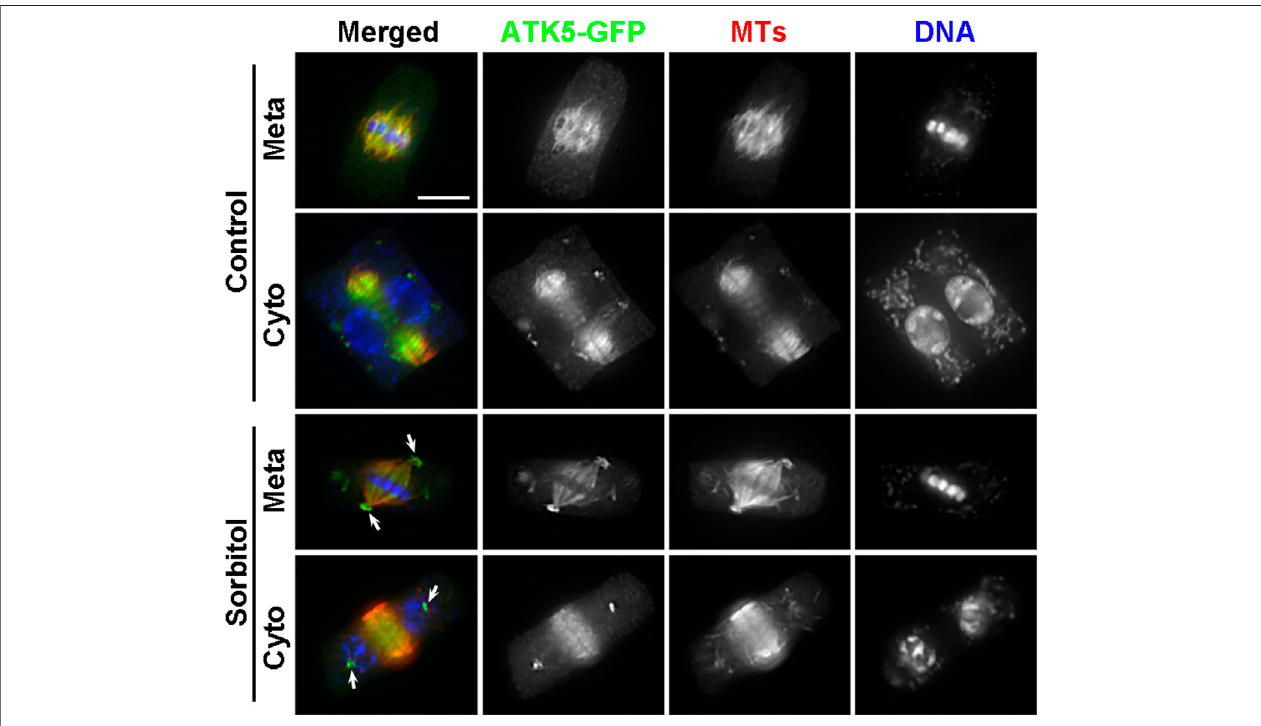
FIGURE5 | Poleward accumulationofATK5-GFP upon sorbitol treatment in A . thaliana . The ATK5-GFPsignal largelyoverlapswith thatofMTs in both the spindle and phragmoplast arrays. Sorbitol treatment leads to the formation of the pseudo-centrosome foci in a metaphase (Meta) cell (arrows) with the signal on spindle MTs diminishing. The pseudo-centrosomes persist in the cytokinetic cell (Cyto) and appear in sharp foci (arrows) at which MTs are not concentrated. Scale bar, 5 µm.